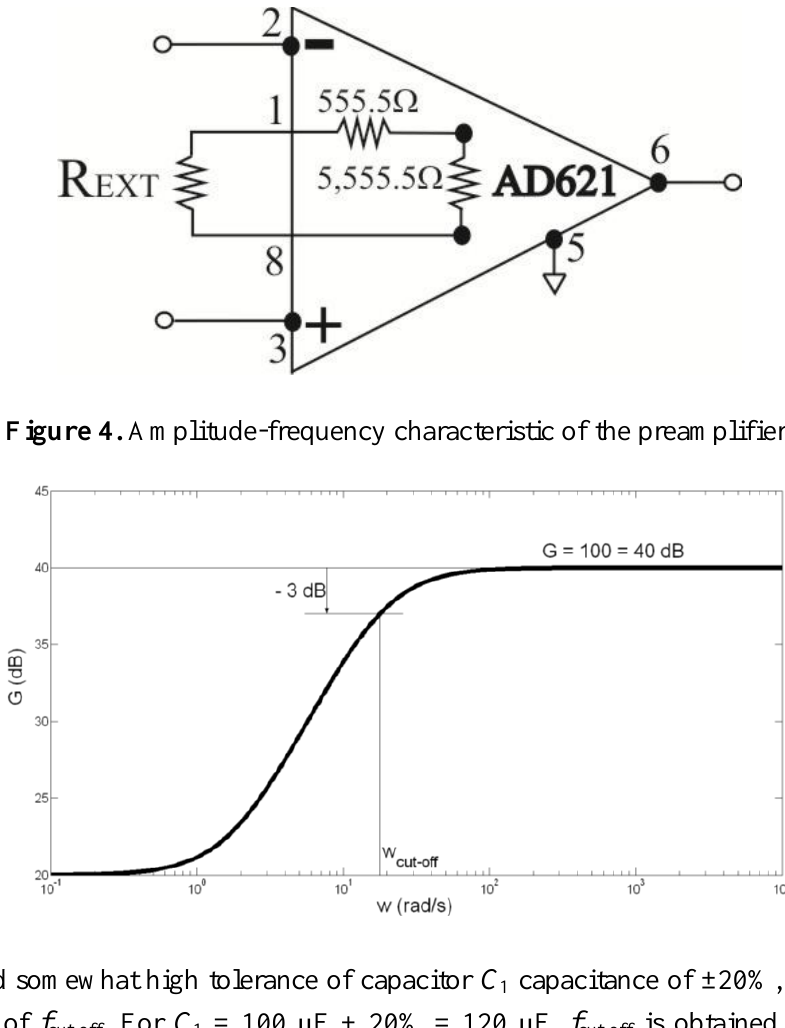
Figure 3. AD621 instrumentation amplifier: Gain setting.